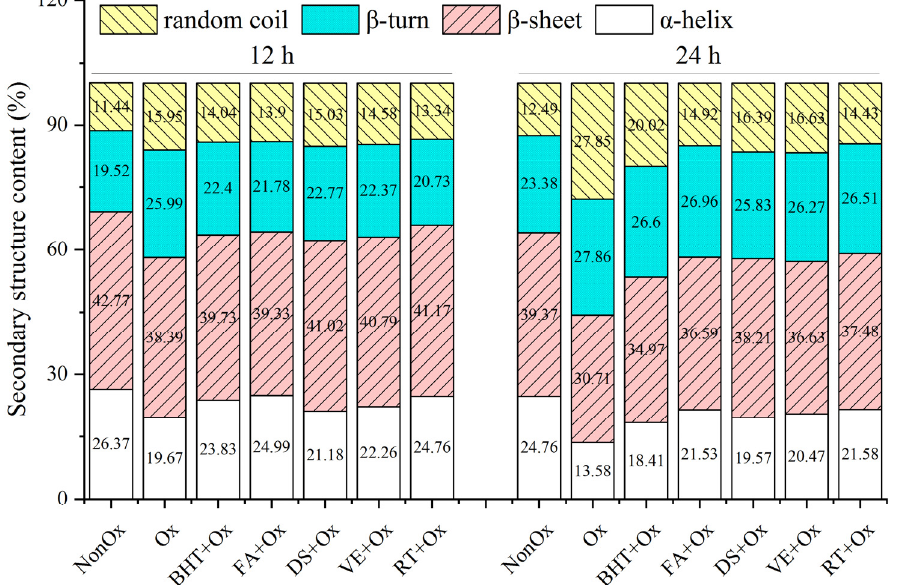
Figure 4. Secondary structural composition of MPs in minced yak meat supplemented with different antioxidants. Note: NonOx—non-oxidized; Ox—oxidized without antioxidant; BHT + Ox, FA + Ox, DS + Ox, VE + Ox, and RT + Ox—oxidized in the presence of BHT, ferulic acid, diallyl sulfide, α -tocopherol, and rutin, respectively.